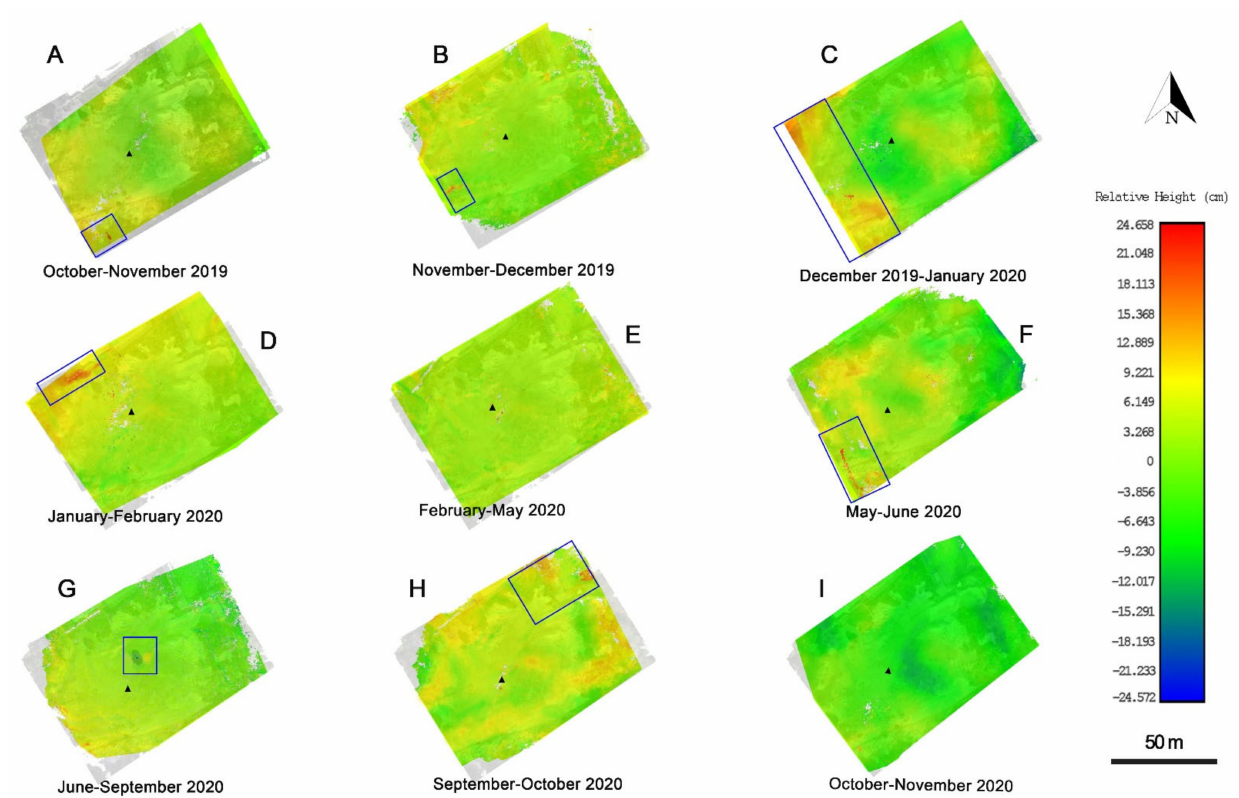
Figure 11. Time-lapse of the relative heights (i.e., differences in height) obtained by comparing the SfM-derived point clouds in pairs. The “Soffione” main vent is indicated with a black small triangular symbol. The blue box indicates the area characterized by strong